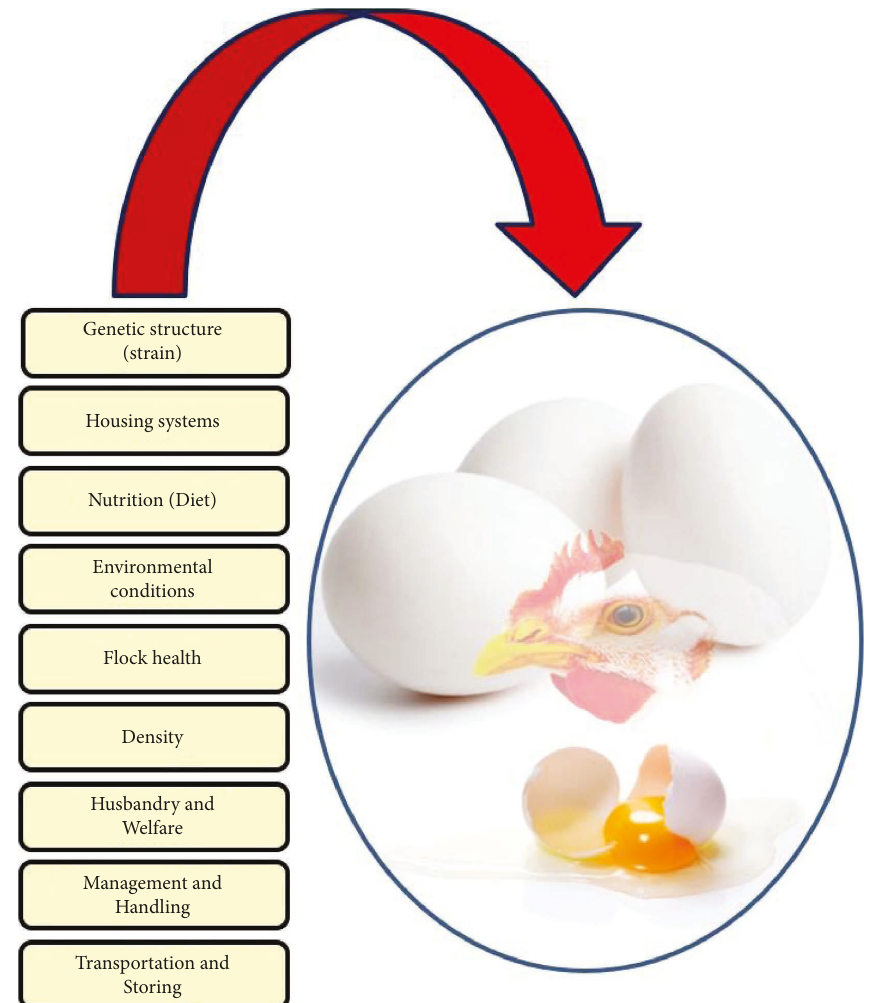
Figure 2: Schematic overview of the main factors that can affect egg production and